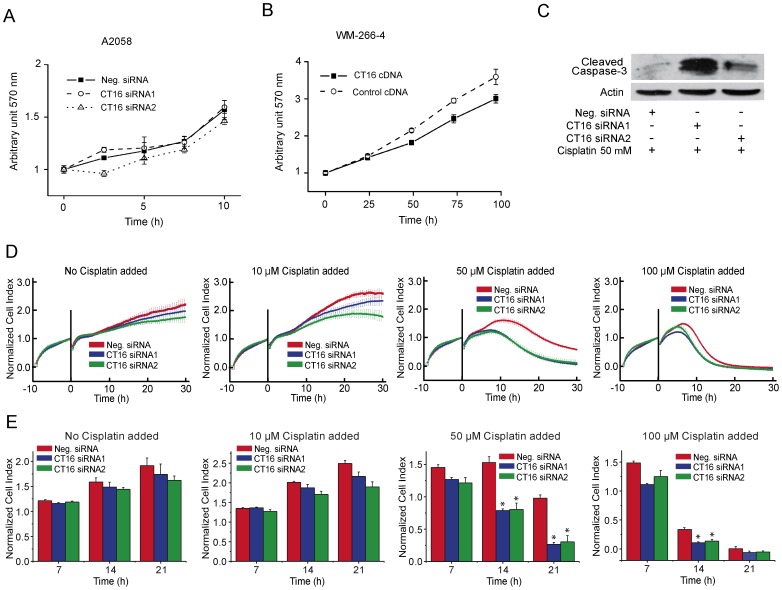
Effect of CT16 on cell proliferation and cisplatin-induced apoptosis.(A) The A2058 cells treated with CT16 specific or control siRNA were subjected to Cell titer 96 proliferation assay. The solubilized formazan dye product was quantified spectrophotometrically at 570 nm. (B) Proliferation of WM-266-4 stably transfected with CT16 or control cDNA. (C) CT16 siRNA transfected A2058 cells were treated with 50 µM cisplatin for 17 hours to induce apoptosis and cell lysates were blotted for cleaved caspase-3. (D) A2058 cells pretreated with indicated siRNA for 48 h were allowed to attach to the xCELLigence plate for 10 h. The cells were exposed to indicated concentrations of cisplatin at the zero time, and the Cell Index was subsequently measured at 10-min intervals for 30 h. The error bars represent standard deviations of three experiments. The cell index of all samples was normalized to 1 at the zero time. (E) Cross-sections at three time points of the xCELLigence experiment. Asterisks indicate significant difference from control siRNA treatment, P<0.001 (ANOVA, Tukey's HSD).